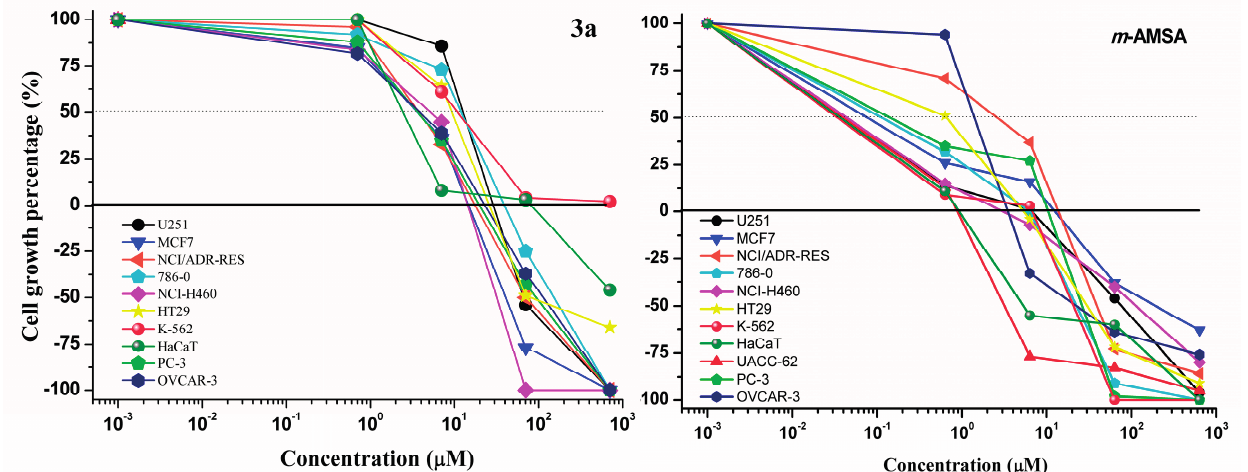
Figure 4. Antiproliferative activity of 3a (concentrations of 0.7, 7.0, 70 and 702 µM) and amsacrine ( m -AMSA) (concentrations of 0.6, 6.35, 63.5 and 635 µM) against nine cancerous cell lines: U251 (glioma, SNC); MCF-7 (breast adenocarcinoma); NCI-ADR/RES (ovary, multidrug resistance phenotype); 786-O (kidney); NCI-H460 (lung non-small cell adenocarcinoma); PC-3 (prostate); OVCAR-3 (ovary); HT-29 (colon); K-562 (Chronic myeloid leukemia) and human keratinocytes